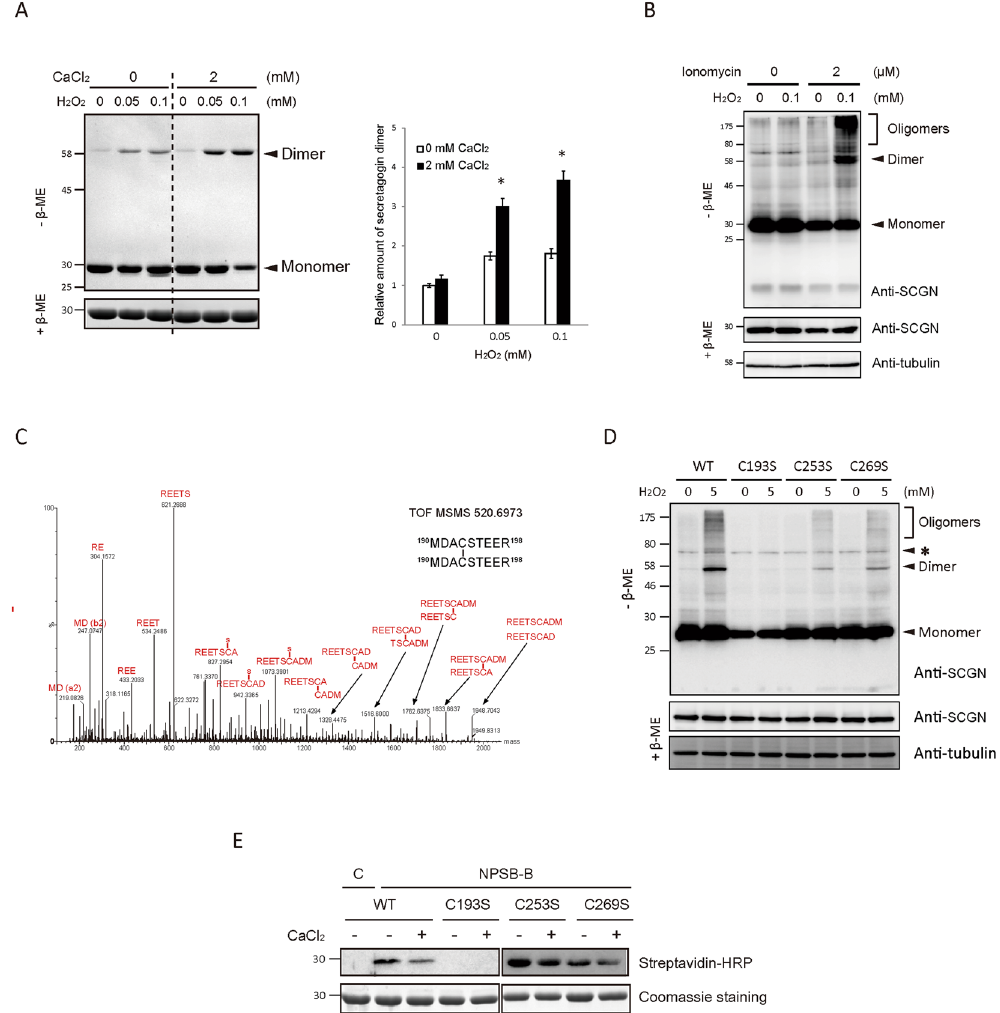
Figure 1. Calcium binding of hSCGN promotes H 2 O 2 induced dimerization via C193-C193 disulfide linkage. ( A ) Recombinant hSCGN was incubated with 0 or 2 mM CaCl 2 at R.T. for 15 min followed by H 2 O 2 treatment in indicated concentration at 37°C for 1 h. Proteins were detected with coomassie blue-staining (left panel) and dimer formations were quantified and normalized with reduced form of SCGN (right panel). Data are presented as mean ± SD of three experiments ( * P < 0.05, Student’s t-test). ( B ) NIT-1 insulinoma cells overexpressing hSCGN WT were pre-incubated with 0 or 2 μ M ionomycin for 5 min followed by incubation with 0 or 100 μ M H 2 O 2 for 30 min at 37 °C. Total protein lysates were analyzed by Western blots using anti-SCGN or anti- α - tubulin antibody. ( C ) Tandem mass spectrum of C193-C193 disulfide linked peptide in band #7 and 8 of Supplementary Fig. S2A. ( D ) HeLa cells overexpressing SCGN WT, and Cys mutant (C193S, C253S, C269S) were treated with 0, 5 mM H 2 O 2 for 10 min at 37°C. The total lysates were separated on non-reducing and reducing SDS PAGE and hSCGN and tubulin were detected by Western analysis. Tubulin was used for loading control. Non-specific bands were indicated as * . ( E ) hSCGN WT, and Cys mutants were incubated with 2 mM CaCl 2 at R.T. for 15 min followed by treatment with 1 mM NPSB-B at R.T. for 2 h. Proteins were separated on reducing SDS-PAGE and detected by streptavidin-HRP. Coomassie staining gel showing amount of gel loaded proteins. Full-length gels and blots are in Supplementary Fig.